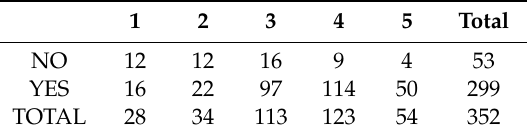
Table 8. Assessment of the experience in Open Access publishing (1 to 5), against the opinion on the future increase in Open Access publications (YES /